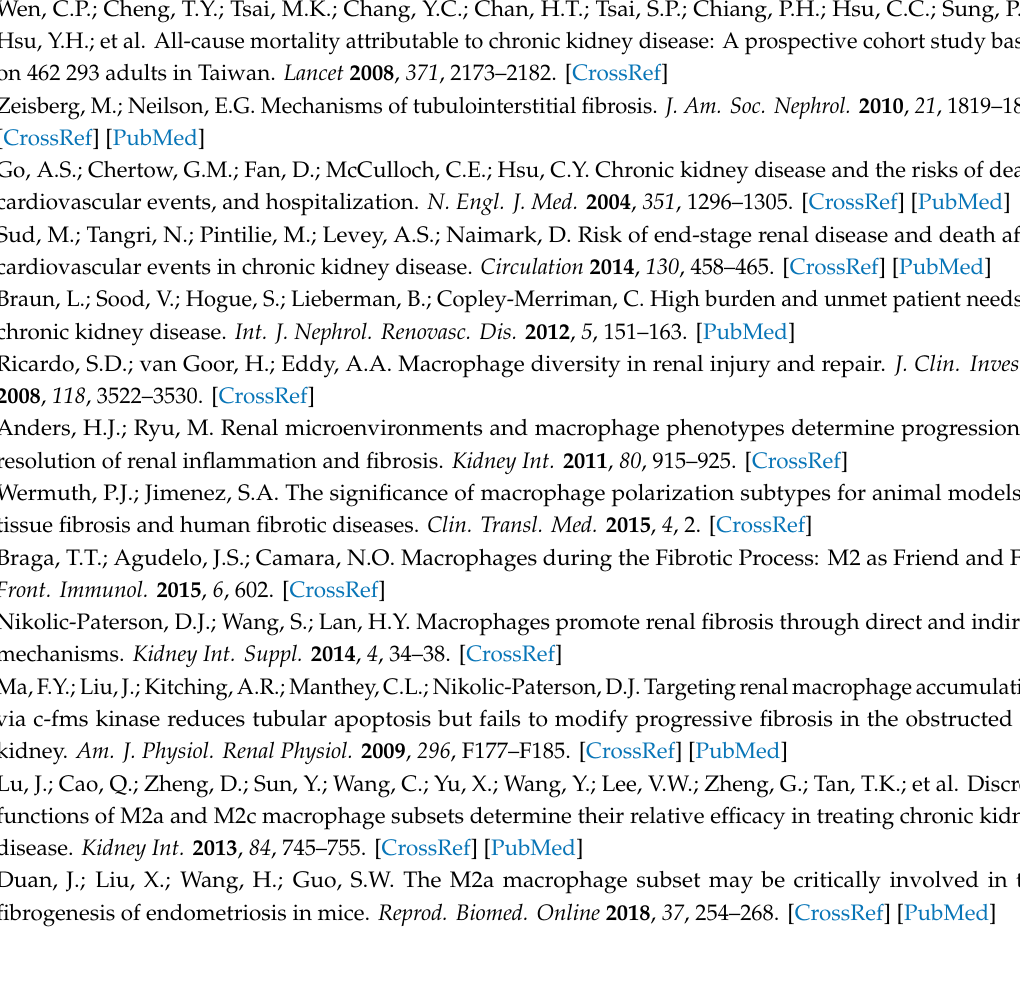
Figure S1. The e ff ect of trichostatin A (TSA) on the activation of renal